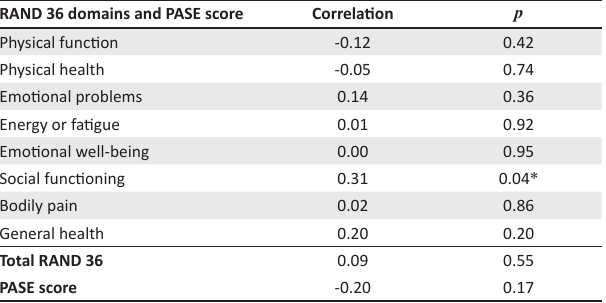
TABLE 3: Pearson’s correlation of RAND 36 domains and PASE score of old age home and community dwellers ( n = 80).